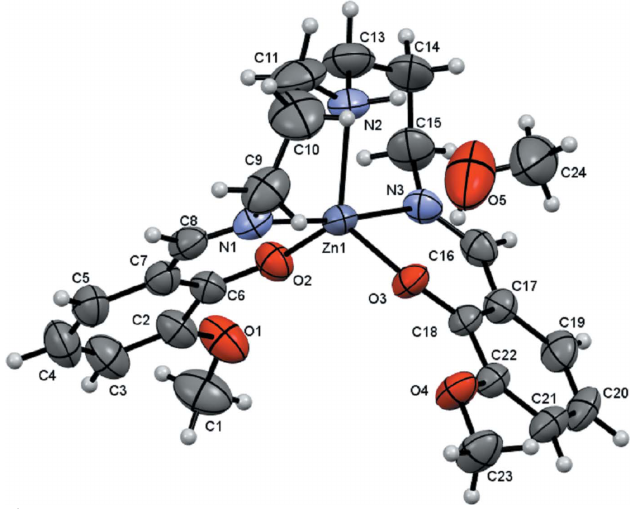
Figure 2 A view of the O5—H5 A (cid:2)(cid:2)(cid:2) O3 and C10—H10 B (cid:2)(cid:2)(cid:2) O5 interactions (dashed